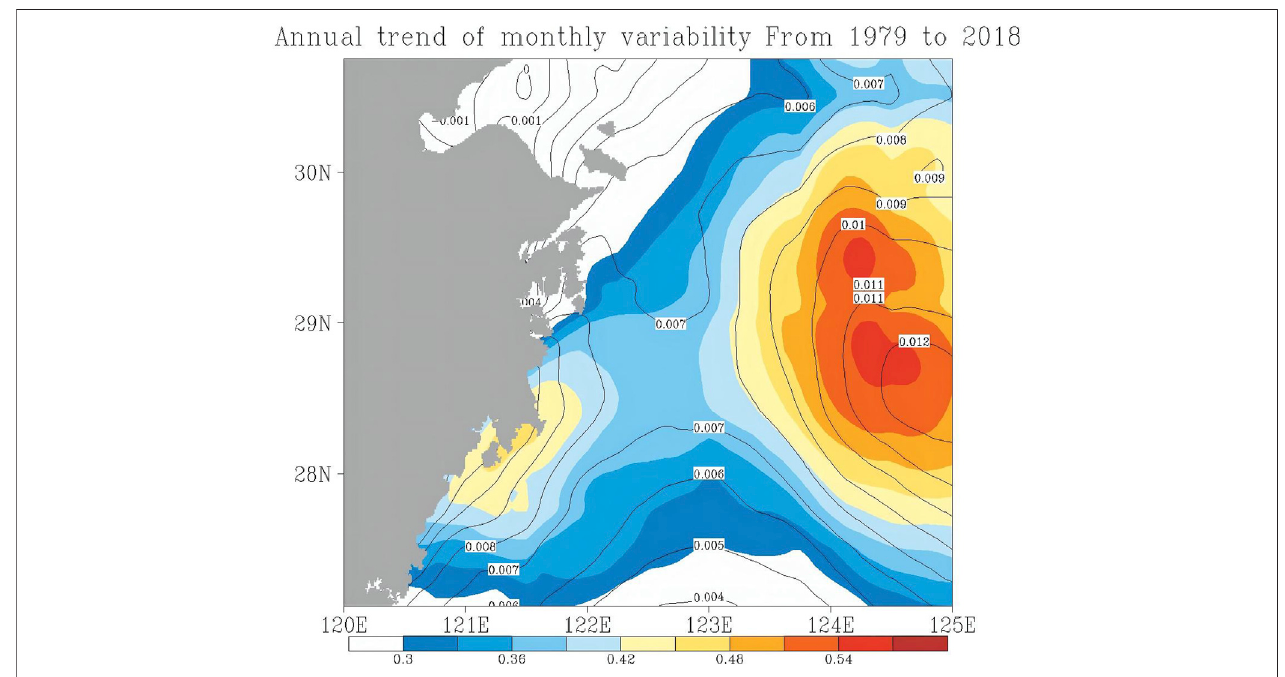
FIGURE 11 | Longterm annual trend of monthly variability index for the period 1979 to 2018.